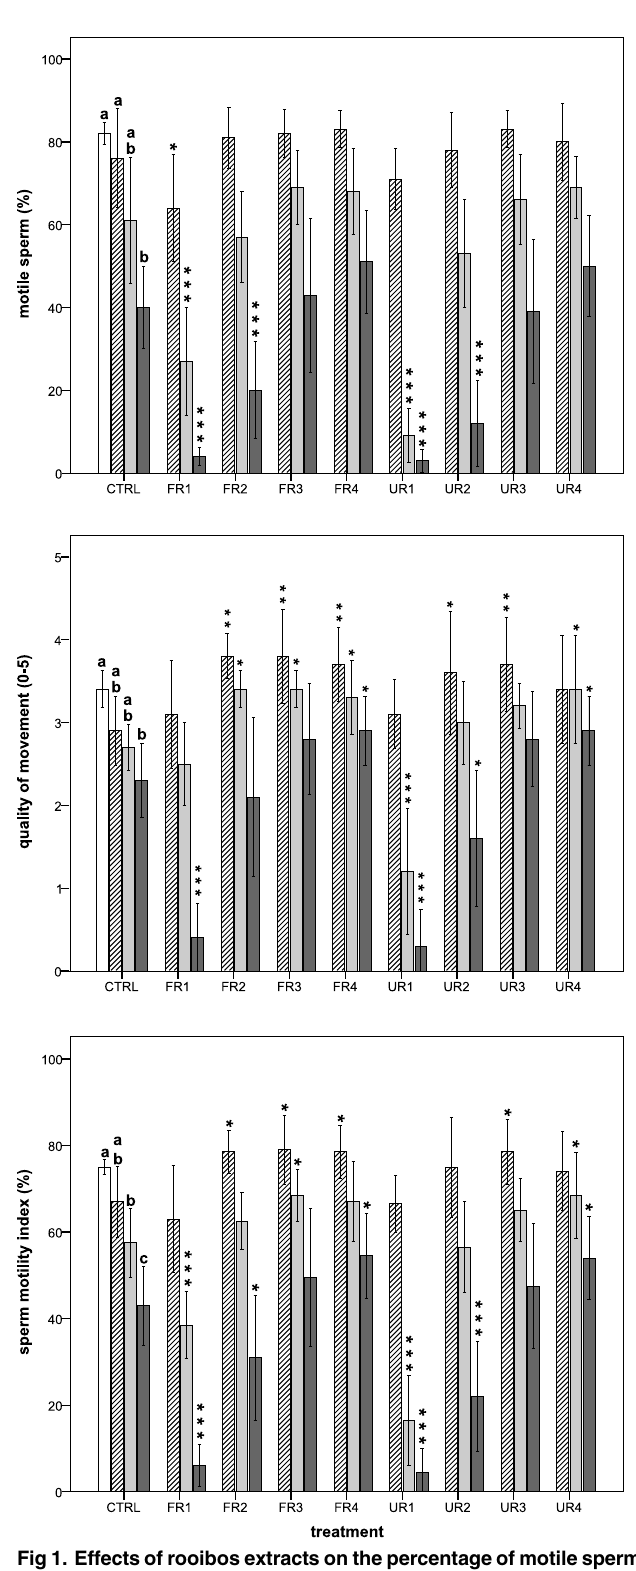
Fig 1. Effects of rooibos extracts on the percentage of motile sperm, quality of movement, and sperm motility index during boar semen storage. White bars = 0 h; diagonallines bars = 2 h; light grey bars = 48 h; dark grey bars = 96 h. Different letters indicatesignificantdifferences( P < 0.05) amongtimes for the control